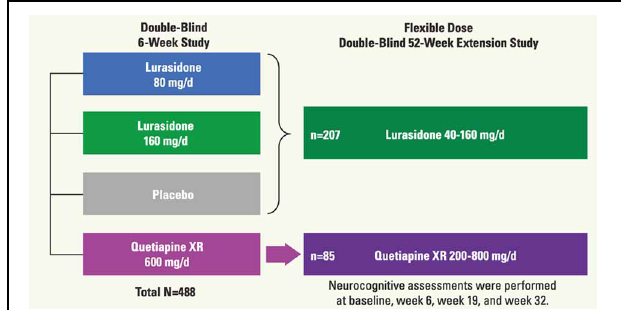
FIGURE 7 | Schema of the protocol for the double-blind study of the effect of lurasidone on cognitive function in patients with acute schizophrenia (Sumiyoshi et al., 2013; 3rd Asian Congress on Schizophrenia Research).